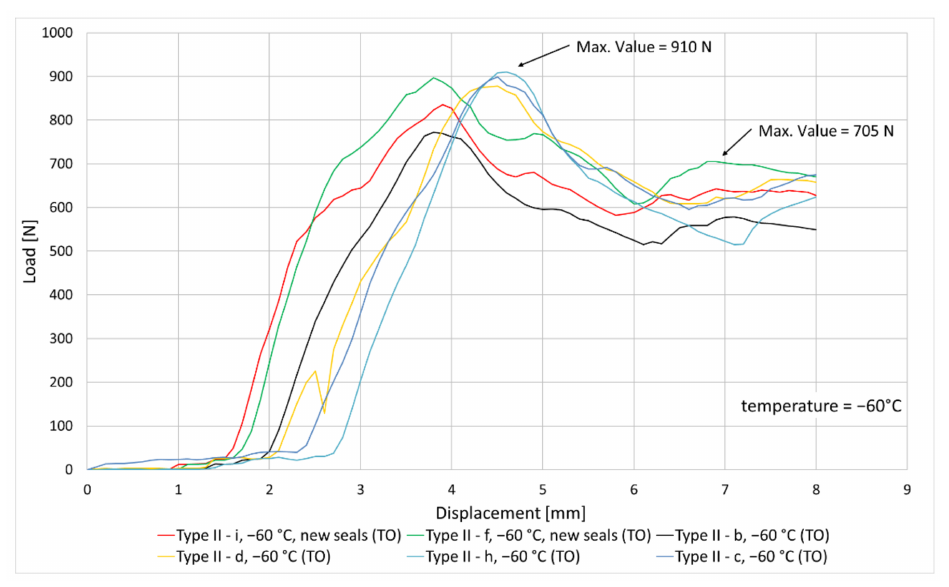
Figure 24. Closing force curves were obtained for Type II seals at − 60 ◦ C with toroidal shaped